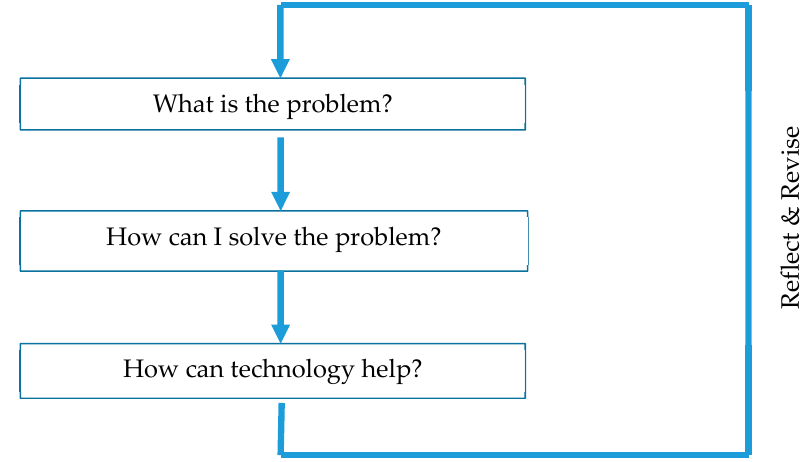
Figure 3. Model for Pedagogy before Technology in a Design-Based Research (DBR) Process.